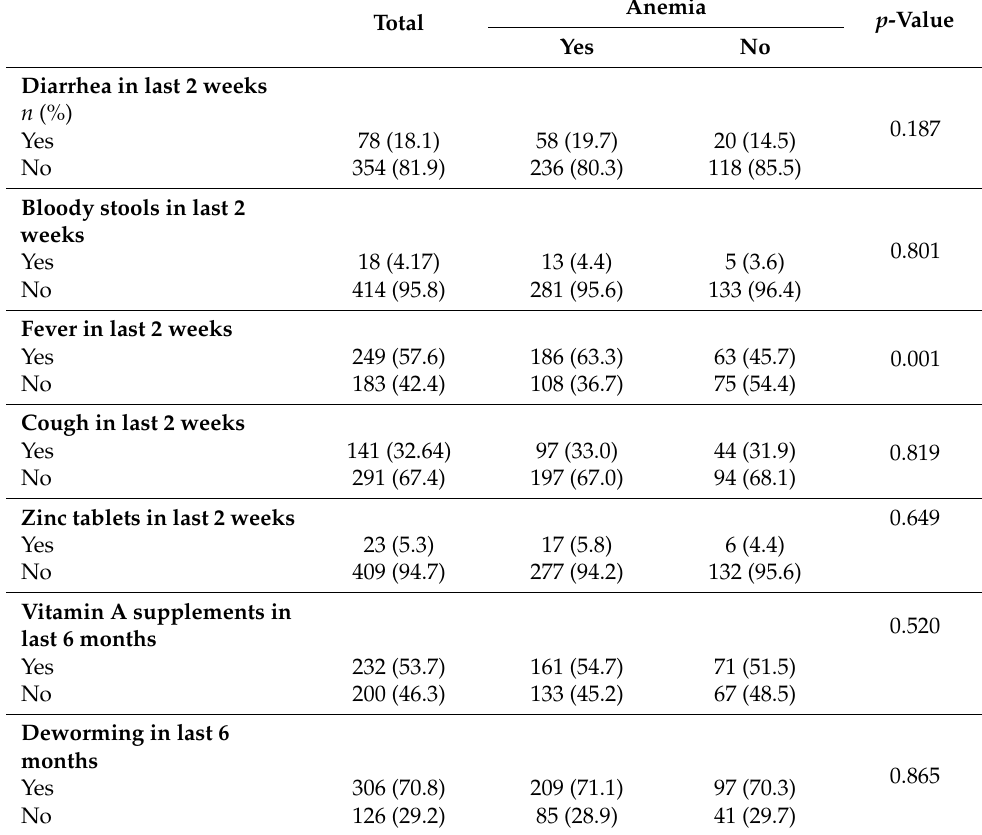
Table A2. Clinical characteristics of children aged 1–5 years in